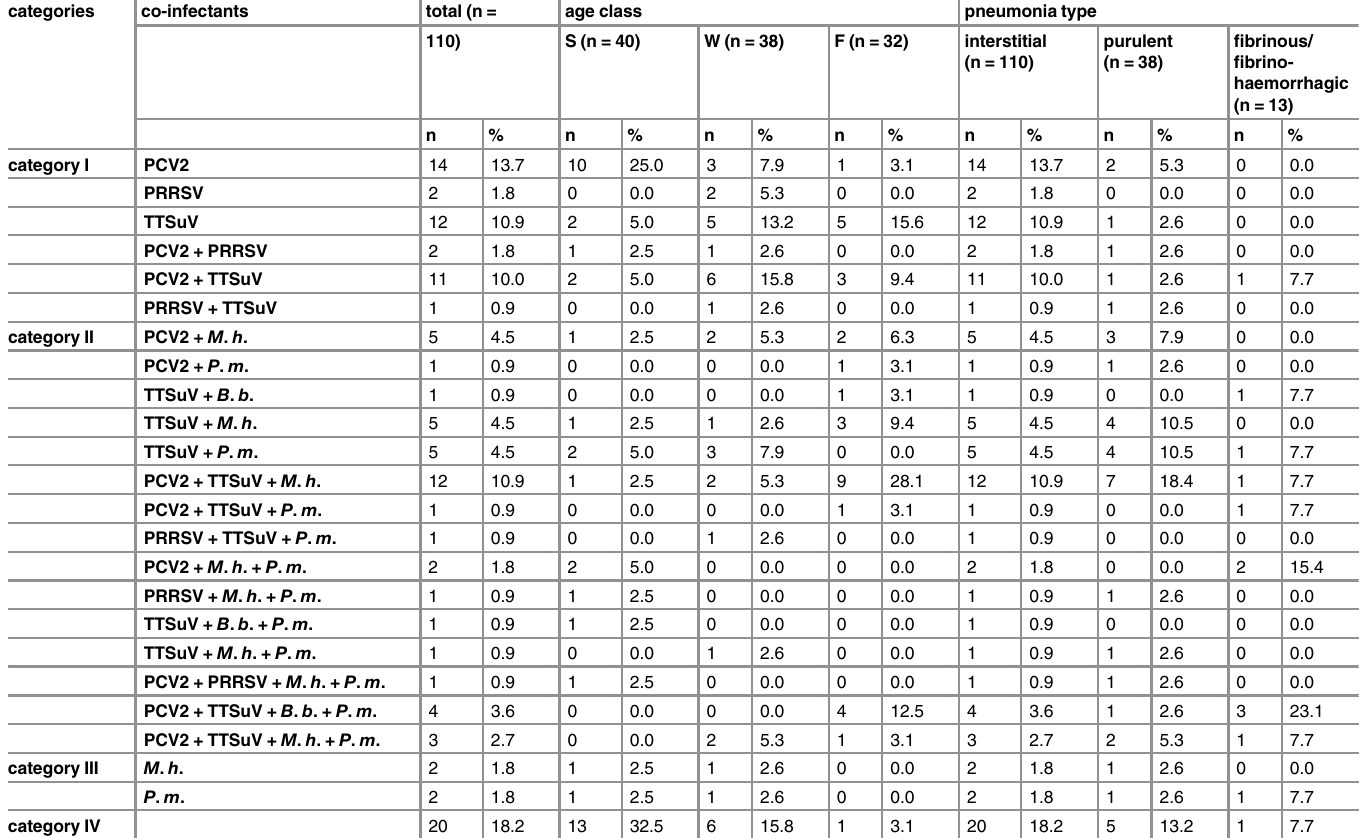
Table 4. Co-infections and Pneumocystis spp. single infections in total as well as their relationships to age classes and pneumonia types. S = suckling piglets, W = weaning piglets, F = fattening pigs; category I: only viral co-infectants, category II: both viral and bacterial co-infectants, category III: only bacterial co-infectants, category IV: Pneumocystis spp. single infection. categories co-infectants total (n =